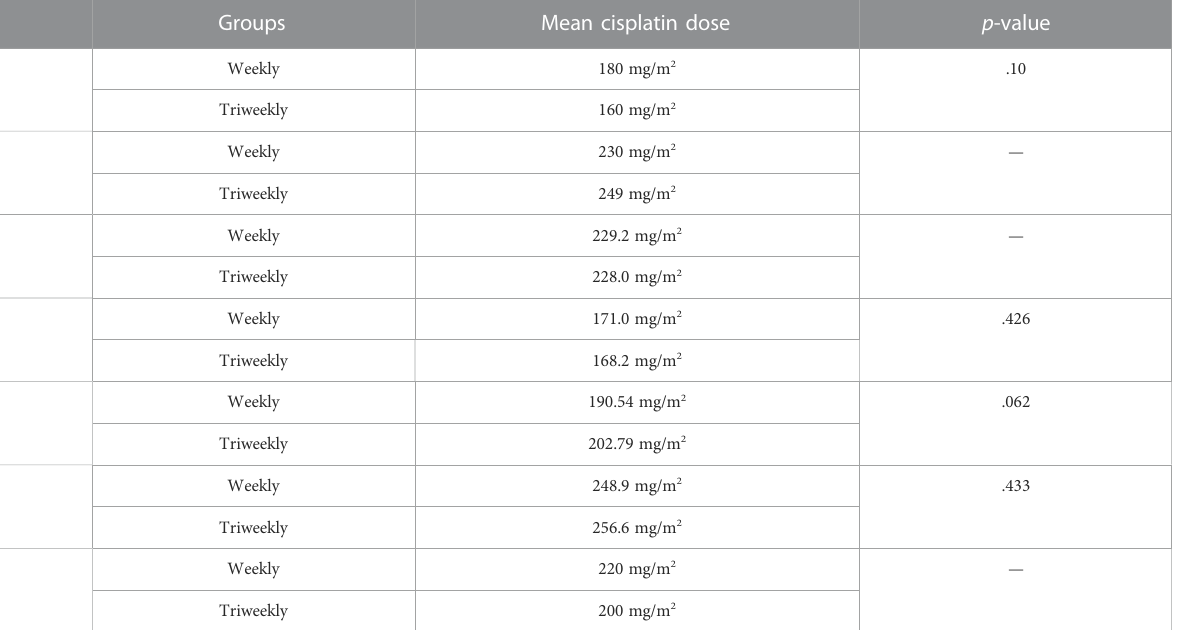
TABLE 2 Summary of mean cumulative dose of